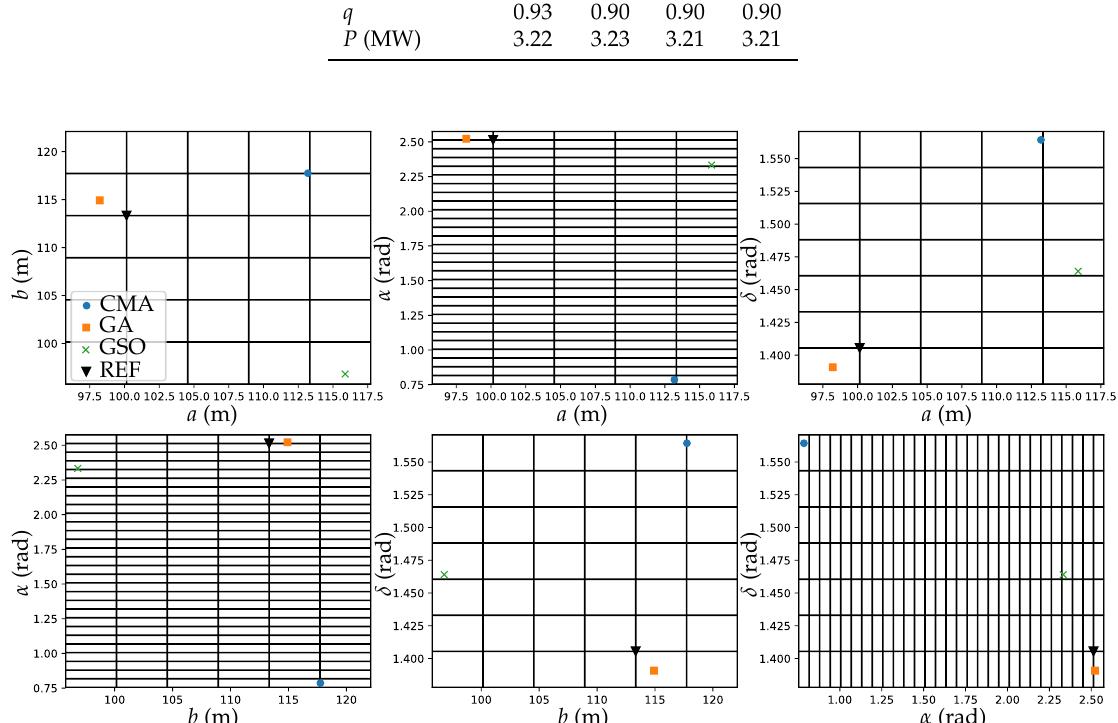
Figure 7. Search-space discretisation (SSD), best layout parameters found by the optimisers, and the reference layout (REF) parameters. Grid points resulting from the SSD are shown as the intersections between black